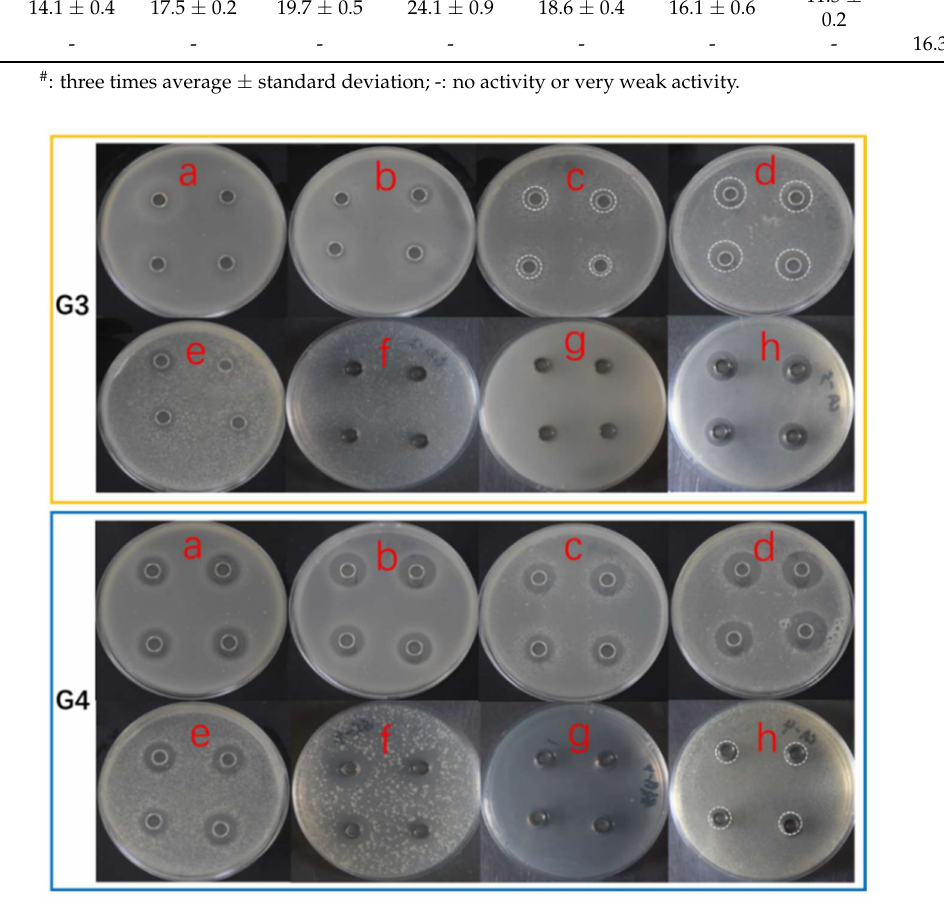
Figure 3. The antimicrobial activities of representative co-cultures (G3 & G4). The figures ( a – h ) for G3 & G4 are the antimicrobial results against MRSA, Bacillus subtilis , Pseudomonas aeruginosa , Vibro parahemolyticus , V. alginolyticus , Shewanella putrefaciens , Yersinia pseudotuberculosis , and Candida albicans , sequentially. For some relatively weak inhibition zones, circles in dash lines were used to mark